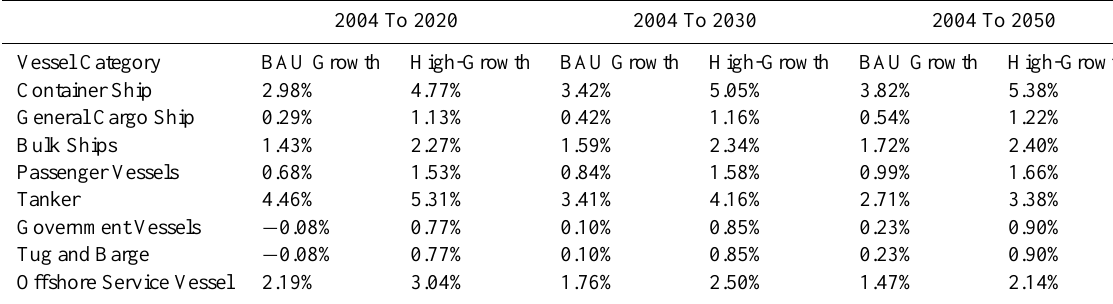
Table 5. Input growth rates by vessel type from scenario model used in IMO study (Buhaug et al.,